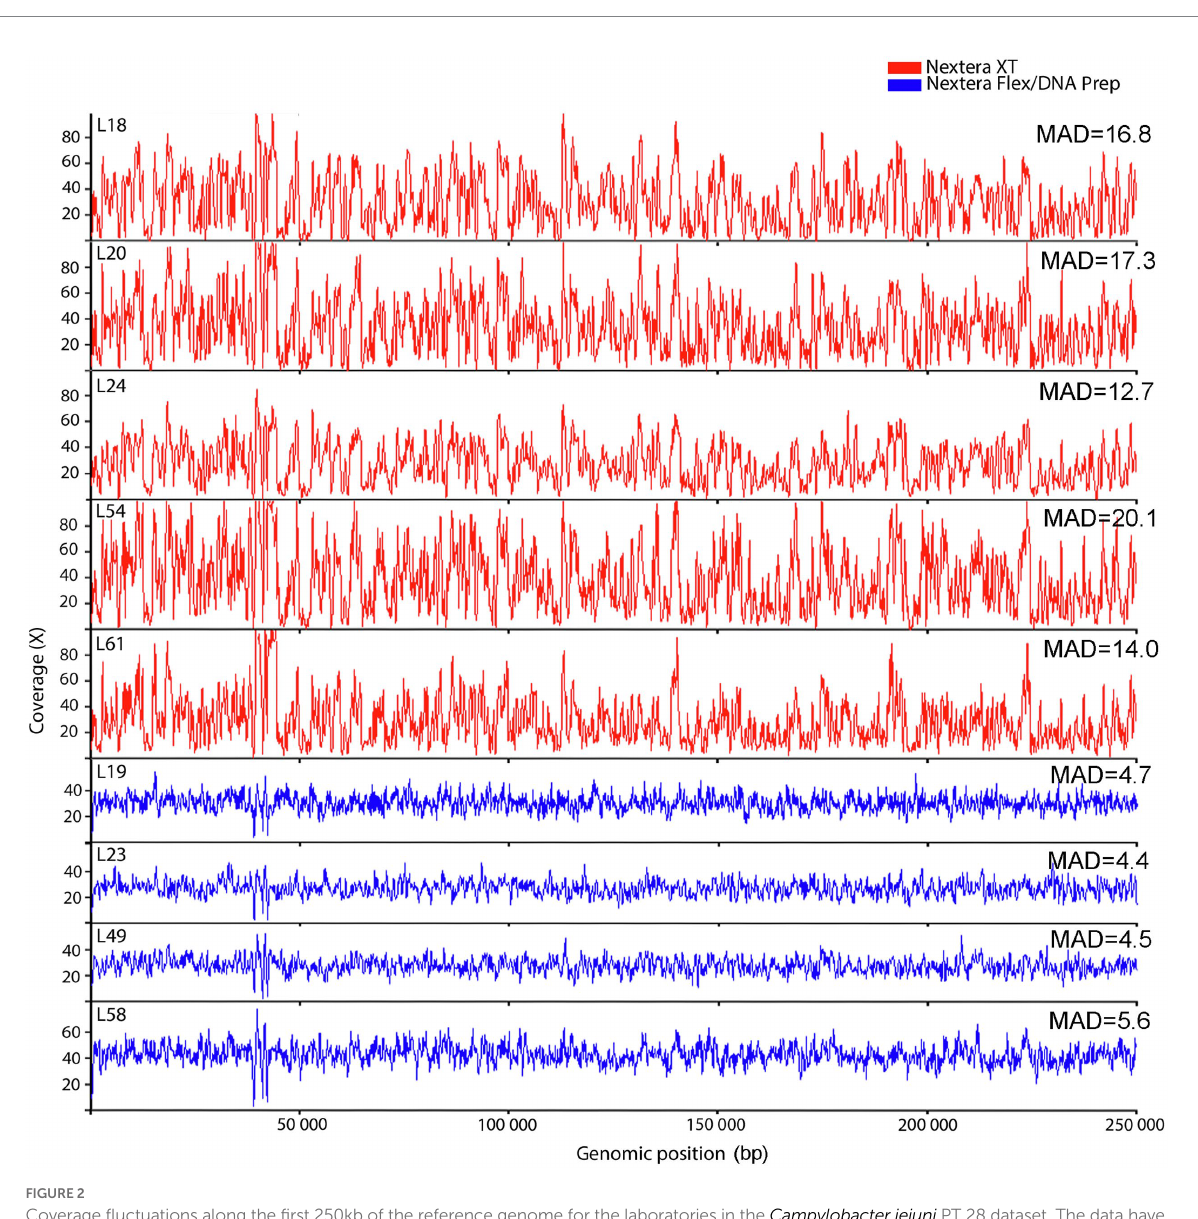
FIGURE 2 Coverage fluctuations along the first 250 kb of the reference genome for the laboratories in the Campylobacter jejuni PT 28 dataset. The data have been downsampled to equal depth and colored to indicate the type of library prep kit used (Nextera XT red, Nextera Flex/DNA Prep blue). MAD refer to Mean absolute deviation.